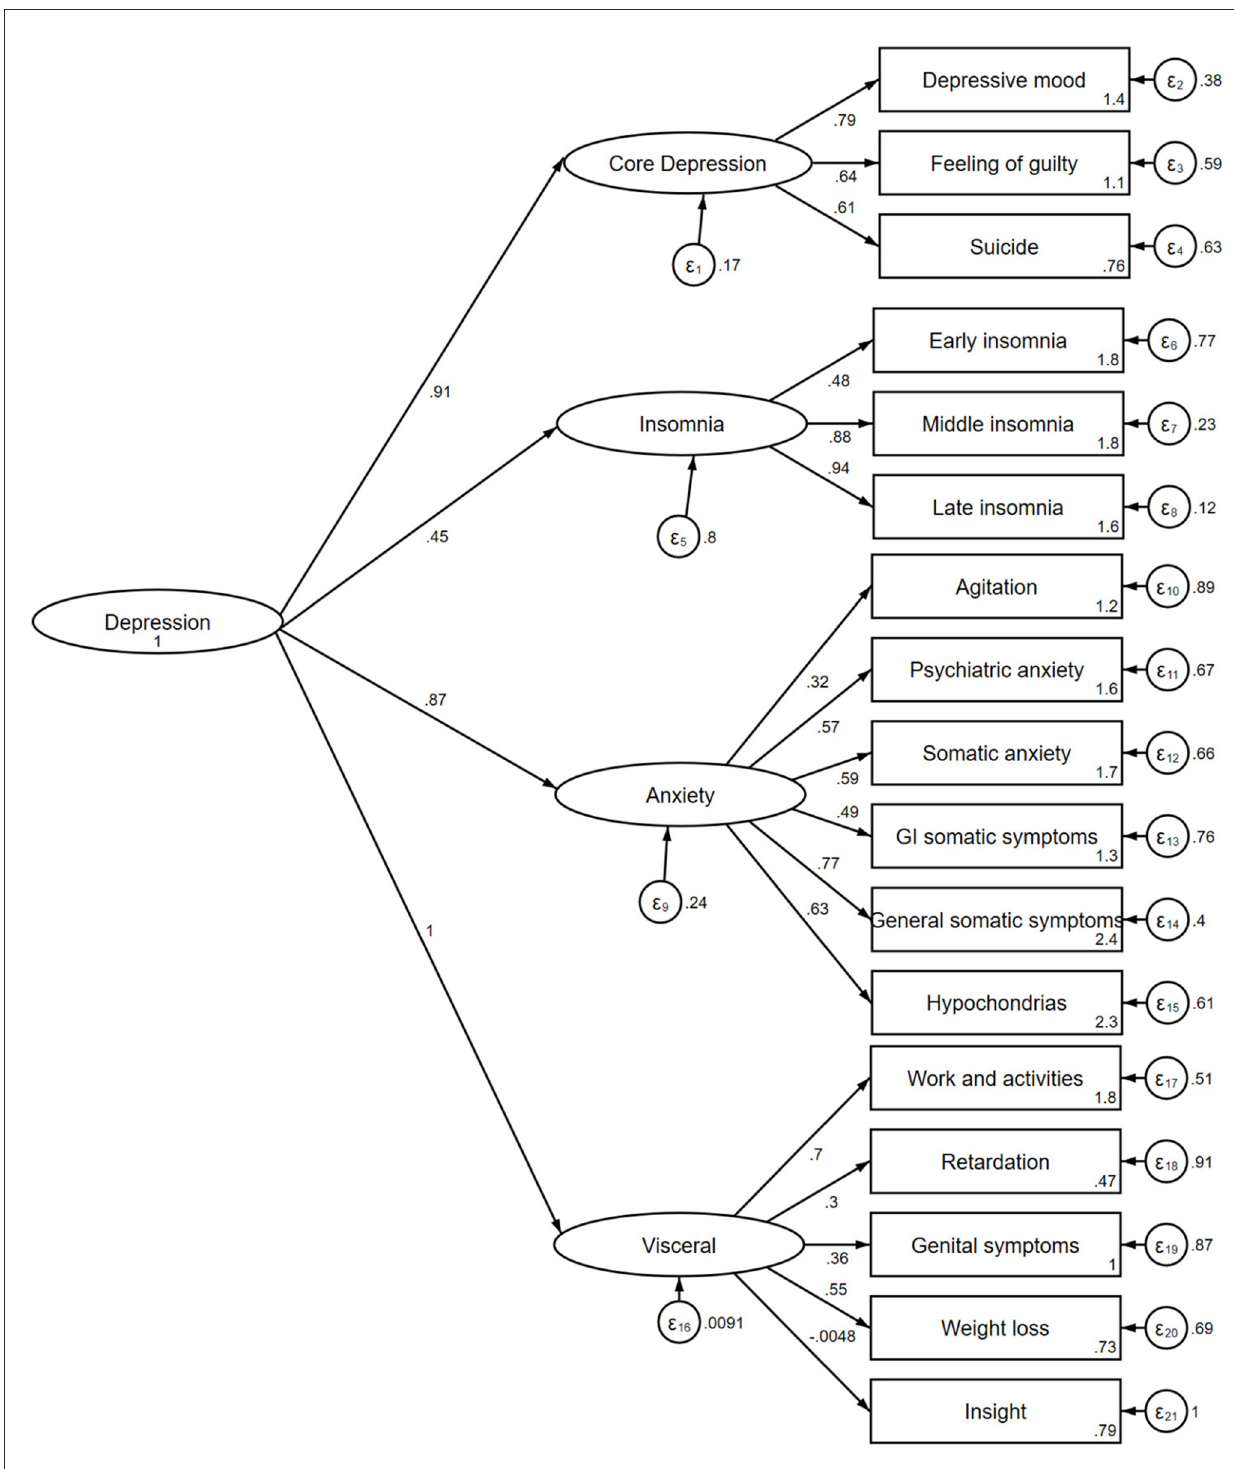
FIGURE2 A second-order factor construct of the Vietnamese version of the Hamilton D-17.